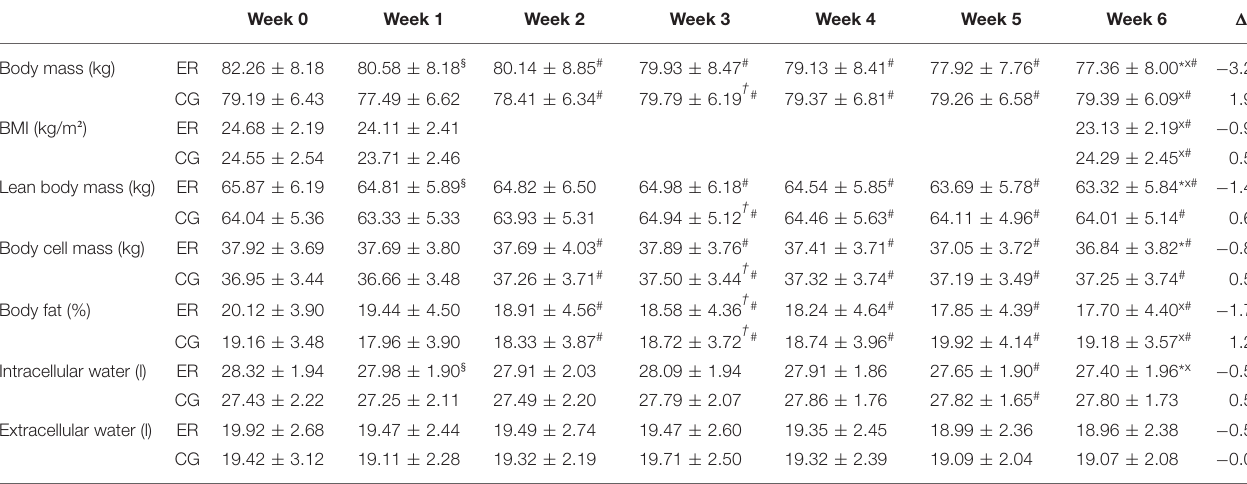
TABLE 2 | Overview of body composition changes in the energy-restricted group (ER) and the control group (CG). Week 0